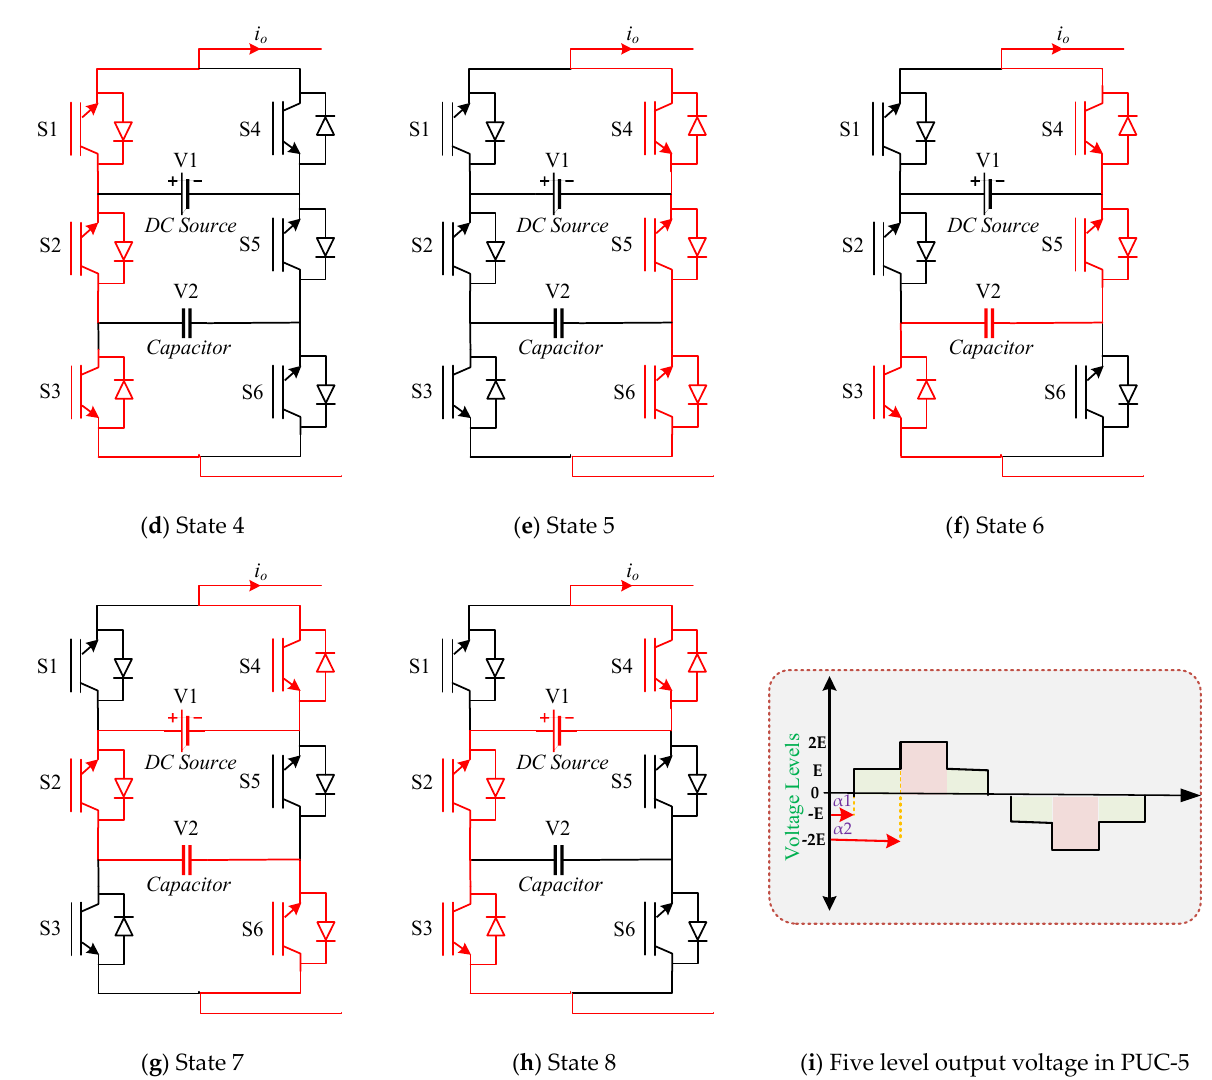
Figure 1. ( a – h ) Various PUC ‐ 5 inverter switching states and ( i ) five ‐ level output in PUC ‐ 5.